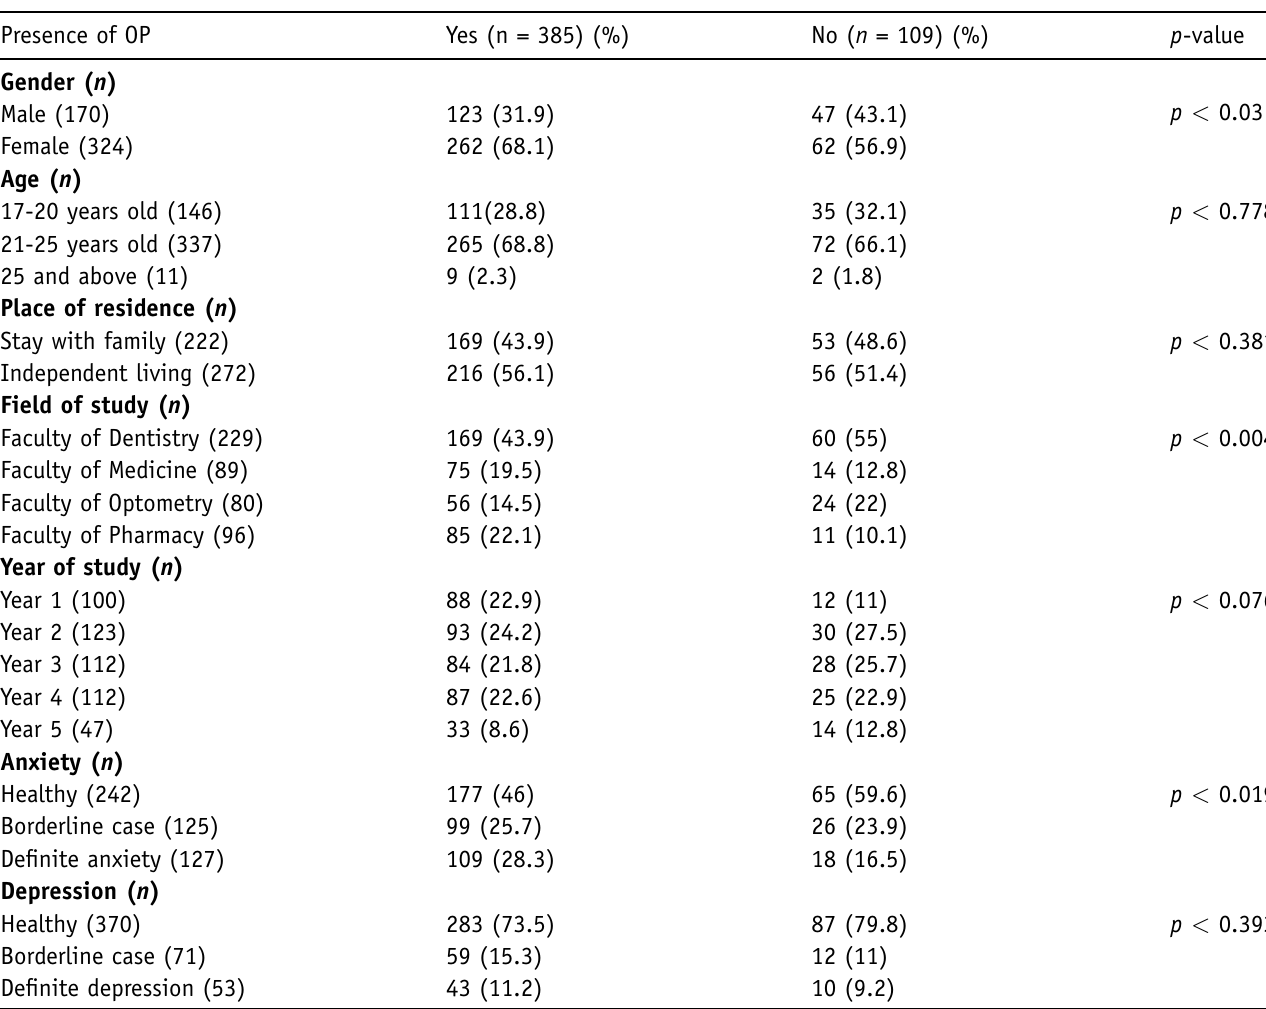
Table I. Sociodemographic characteristics and psychological status of students with OP. Presence of